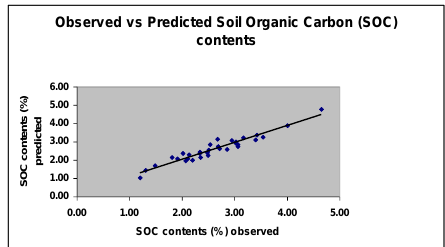
Fig 9 Observed vs Predicted organic carbon maximum numbers of bands used are 8 and 16 for K and S nutrients respectively. Using these coefficients and R, R1 and A1, as applicable, seven nutrient images were created and a sample OC image is depicted in Fig 10.